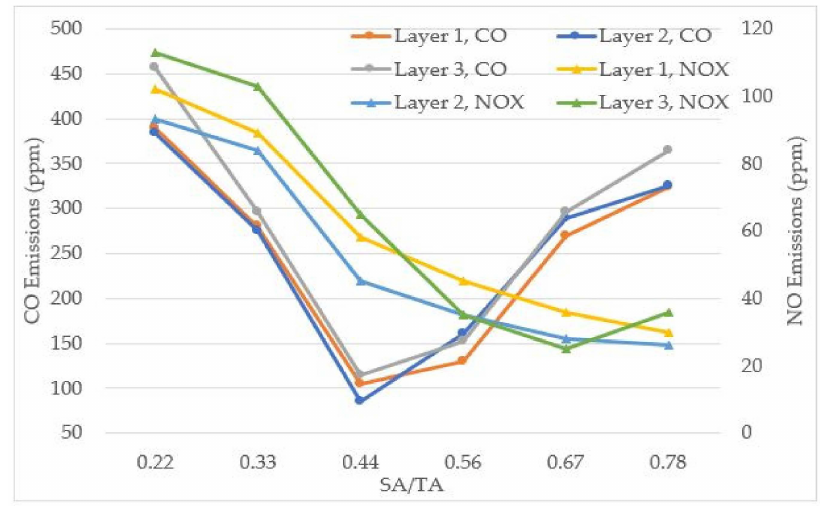
Figure 6. E ff ect of SA / total air (TA) ratios on gaseous